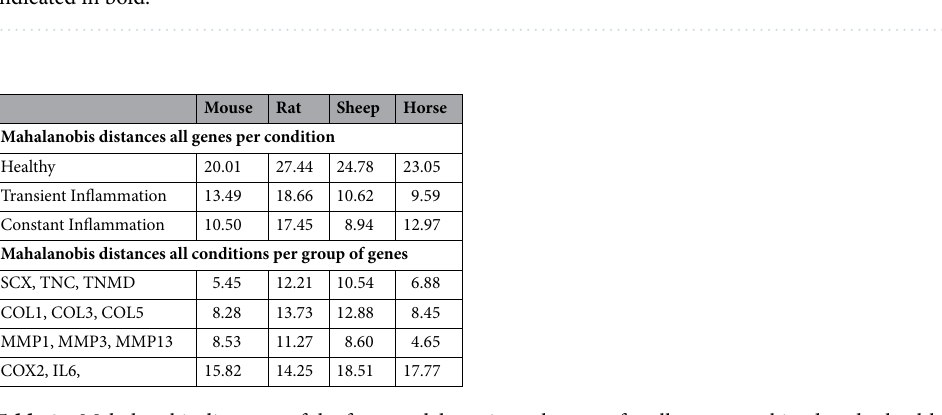
Table 3. Mahalanobis distances of the four model species to humans for all genes combined under healthy, transiently and constantly inflamed conditions as well as for the different functional gene groups: tenogenic markers, collagens, MMPS and inflammatory